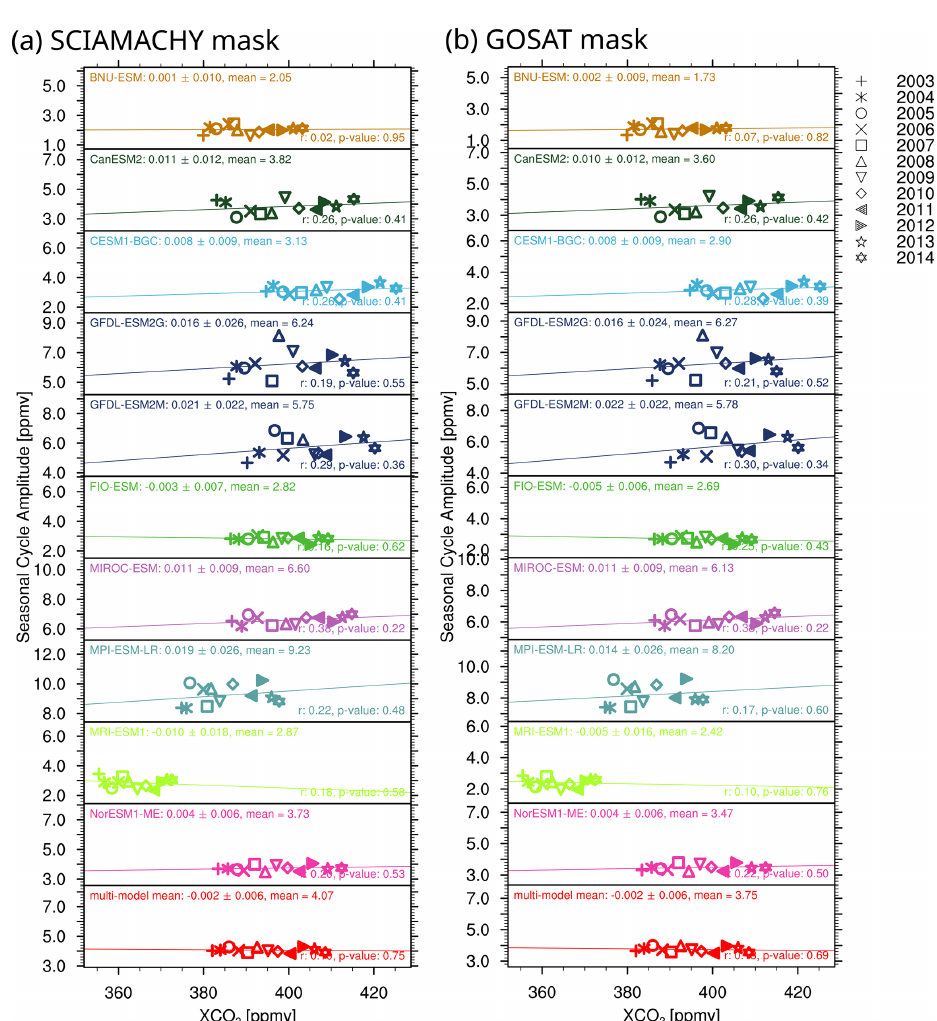
Figure B2. Same as Fig. B1 but with CMIP5 models masked using (a) the SCIAMACHY mask and (b) the GOSAT mask, with the masks derived from Fig. 8, masking out points with less than 50% coverage in those time